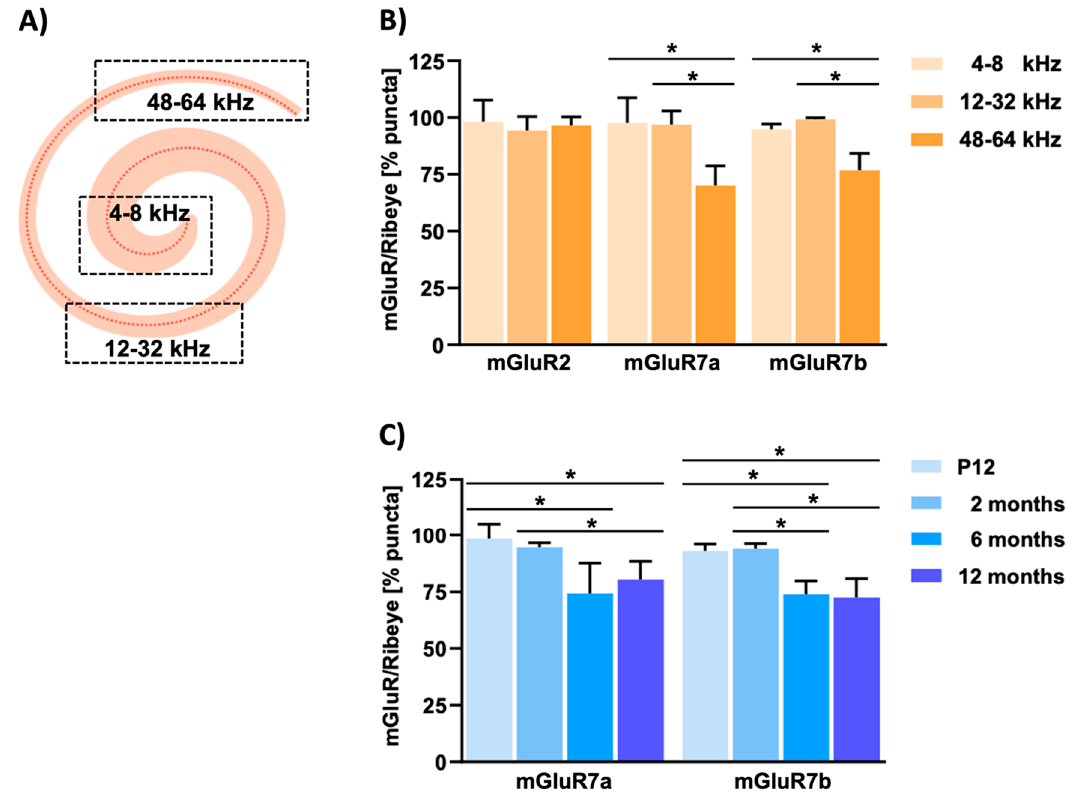
Figure 3. Expression of mGluR7 splice variants is reduced at ribbon synapses of inner hair cells in cochlear regions encoding high frequencies and with age. ( A ) Graphical representation of the cochlear anatomy. Red dots indicate hair cells located along the tonotopic axis of the cochlea. In the mouse, the apical region covers frequencies between 4 to 8 kHz, the middle region between 12 to 32 kHz, and the base is sensitive to frequencies up to 64 kHz. ( B ) The bar diagram shows the percentage of counted fluorescent puncta that represent the different frequencies visualized in different shades of orange normalized to the number of stained ribbons at inner hair cell synapses. The reduction of both mGluR7 isoforms at high frequencies is statistically significant. ( C ) Bar diagram showing the percentage of counted fluorescent puncta of mGluR7a and mGluR7b in mouse cochleae of different ages, as indicated by different shades of blue. Counted puncta were normalized to the number of stained ribbons at inner hair cell synapses, as in ( B ). In 6- and 12-month-old animals a significant reduction in the number of puncta representing mGluR7a and mGluR7b can be observed. Error bars are ± SD, statistical significances were calculated with the one-way ANOVA test, p -values < 0.05 are indicated by one asterisk (*).